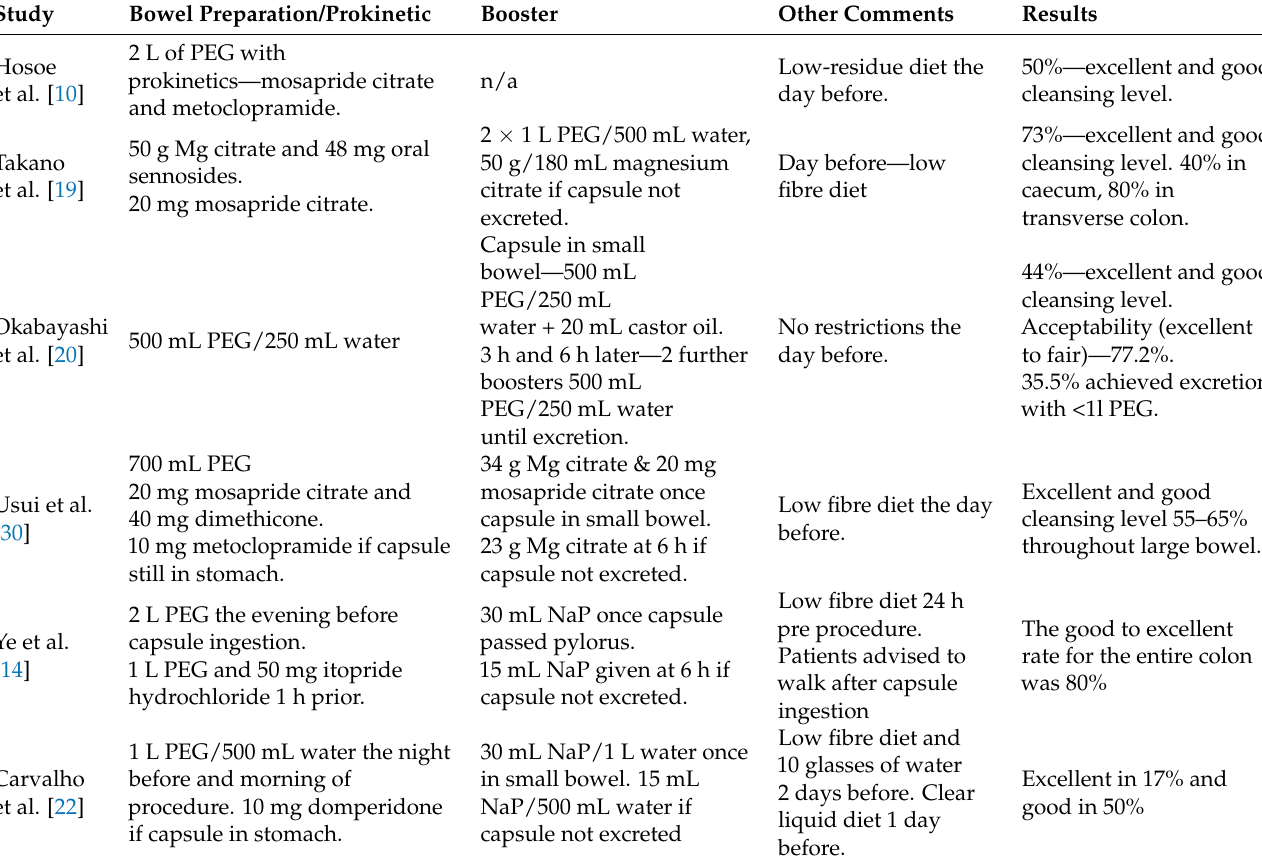
Table 1. Bowel preparation regimens in studies of CCE-2 in